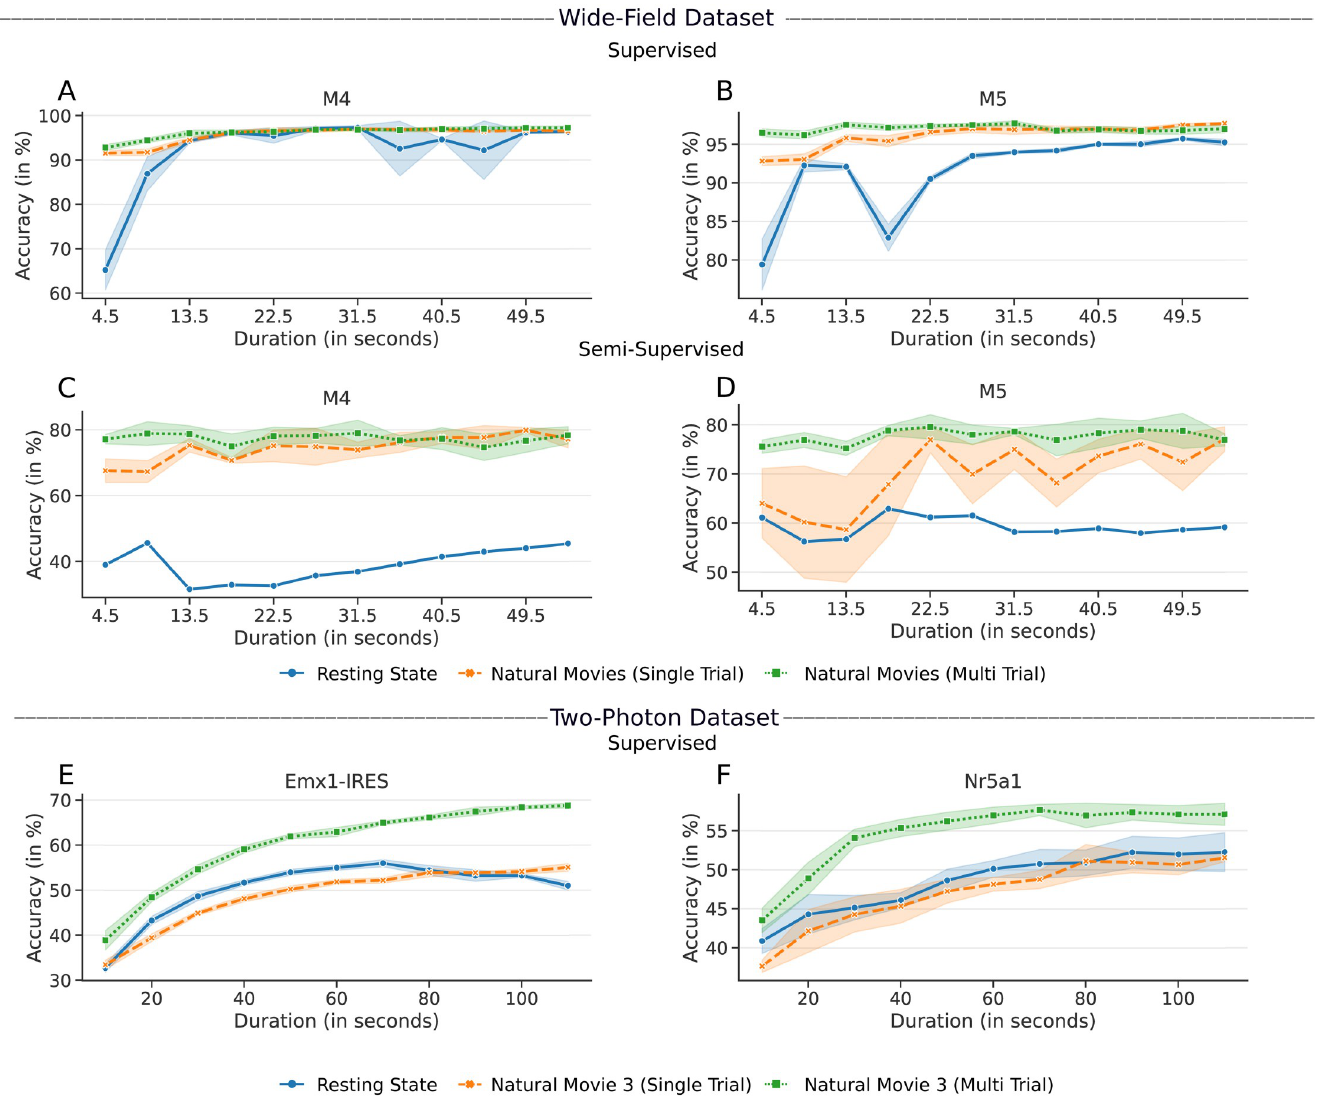
Fig 7. Accuracies obtained by the supervised/semi-supervised pipeline with varying response lengths of resting state and stimulus-induced responses. A , B ) Results for Mouse M4 and M5, respectively, using the supervised approach. C , D ) Results using the semi-supervised approach. E , F ) Results for the two-photon dataset, using the Cre-lines Emx1-IRES and Nr5a1,